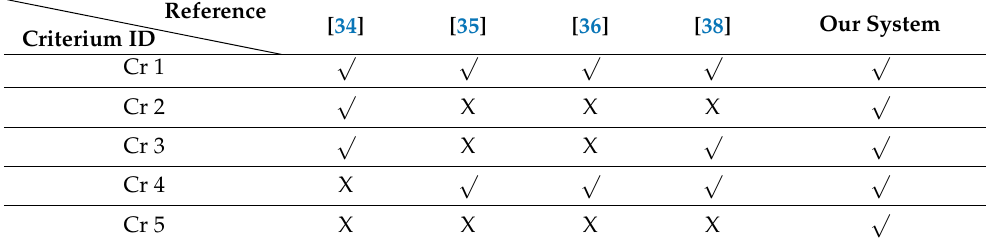
Table 3. Comparison of proposed system with related work. Criterium